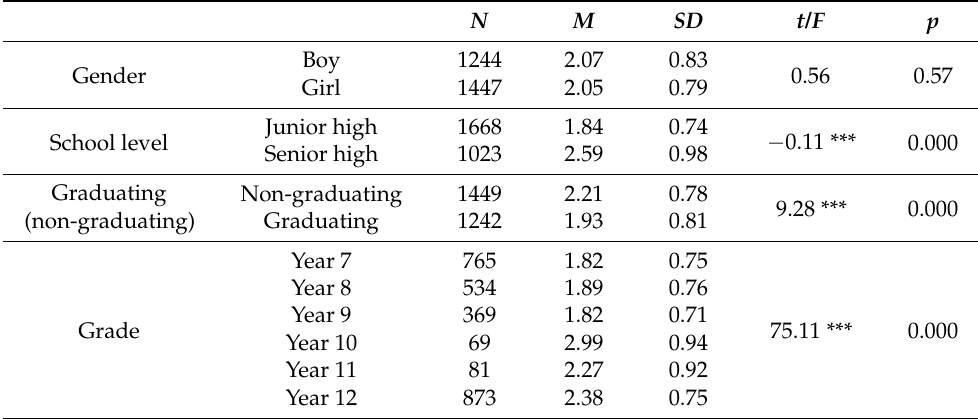
Table 6. ANOVA analysis of stress